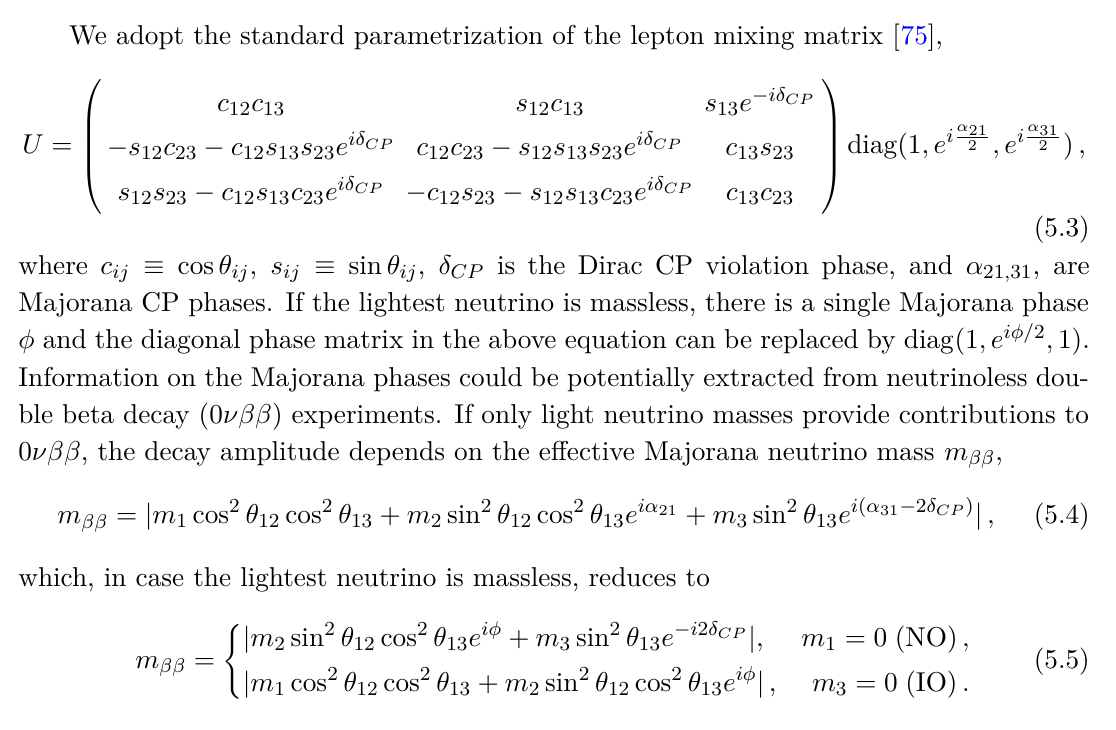
≡ ∆ m 2 > 0 for NO and ∆ m 2 ≡ ∆ m 2 < 0 31 32 3 l 3 l